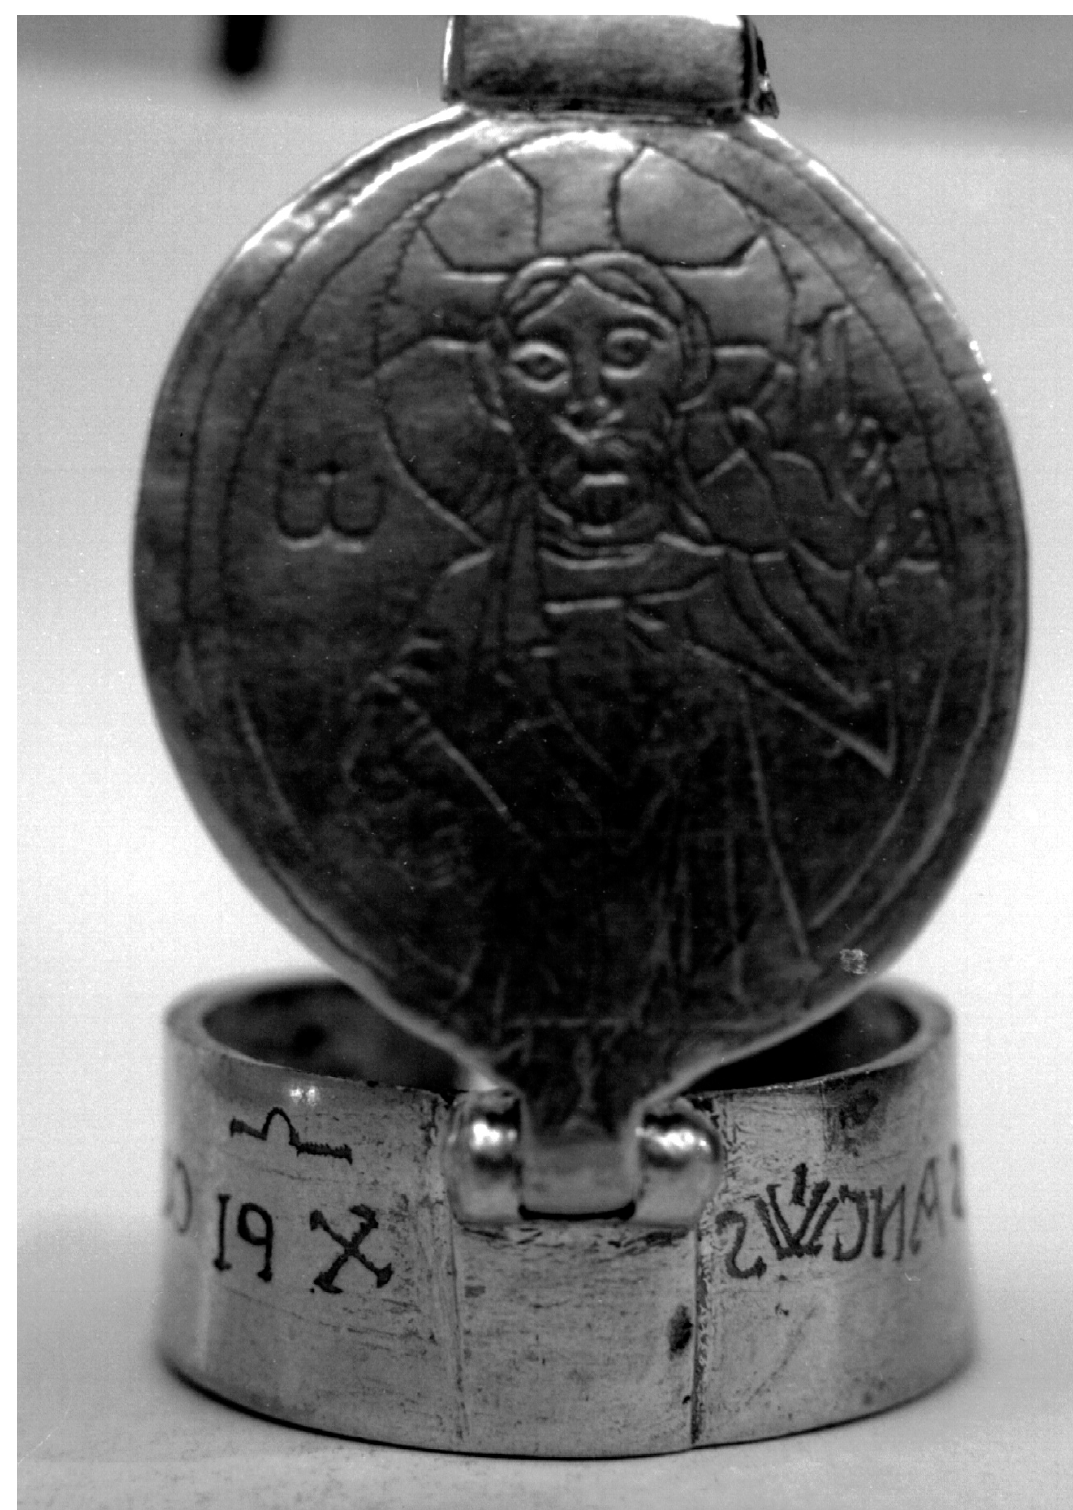
Figure 3. Outer reliquary capsule associated with the sainte Vertu, silver gilt and niello, late eleventh century, treasury of the abbey Saint-Sauveur de Charroux (Photo by permission: Ferron © Ministère de la Culture, Médiathèque du patrimoine et de la photographie, diffusion. RMN-GP).